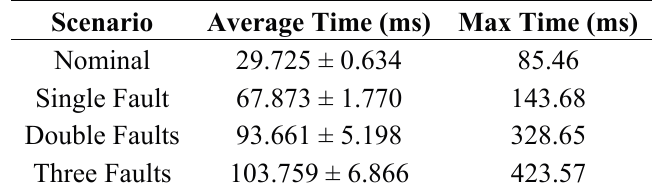
Table 4. Time statistics with single-step mode estimation (confidence 95%).